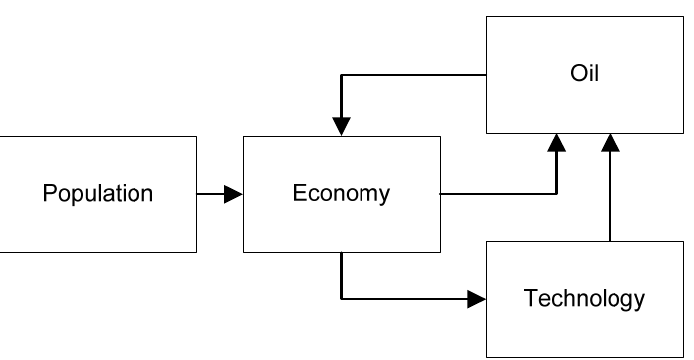
Figure 5. The conceptual framework of the